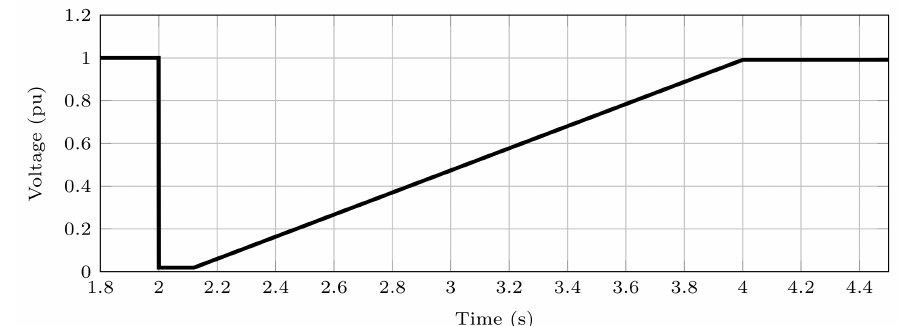
Figure 6. LVRT condition for wind turbine systems.